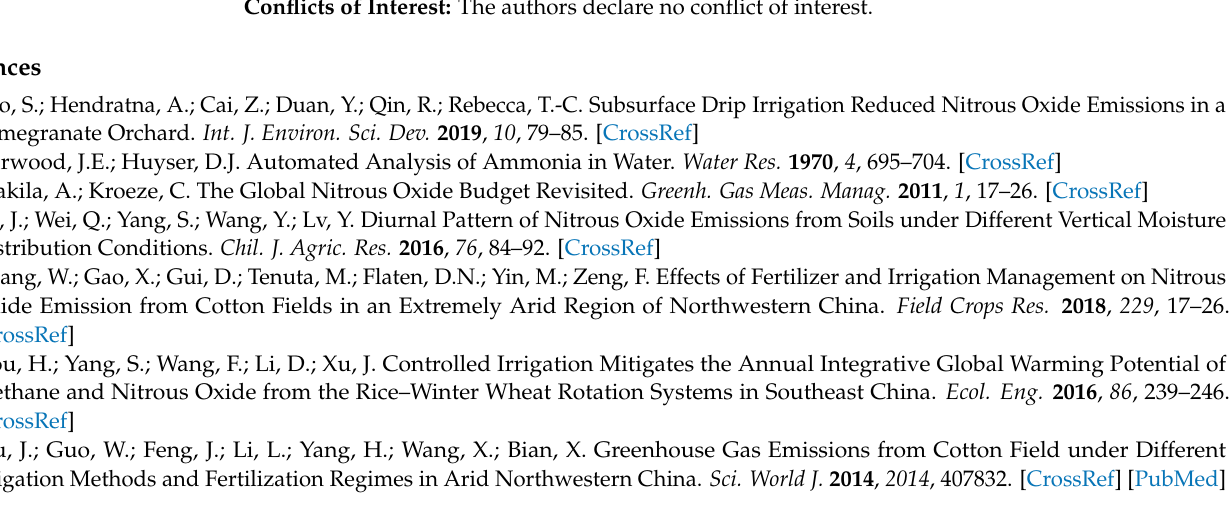
Supplementary Materials: The following are available online at https://www.mdpi.com/article/10 .3390/agronomy12030745/s1, Figure S1: Soil moisture distribution under SDI10+N300 treatment. letters a, b, and c represent first, second, and third irrigation events. The subscript numbers 1, 2, 3, and 4 denote sampling times of soil moisture subsequent to each irrigation; Figure S2: Soil moisture distribution under SDI15+N300 treatment. letters a, b, and c represent first, second, and third irrigation events. The subscript numbers 1, 2, 3, and 4 denote sampling times of soil moisture within each irrigation; Figure S3: Soil moisture distribution under SDI 10 + N 240 treatment. Letters a, b, and c represent first, second, and third irrigation events. The subscript numbers 1, 2, 3, and 4 denote sampling times of soil moisture subsequent to each irrigation; Figure S4: Soil moisture distribution under SDI 15 + N 240 treatment. letters a, b, and c represent first, second, and third irrigation events. The subscript numbers 1, 2, 3, and 4 denote sampling times of soil moisture within each irrigation, Table S1: Soil average ± standard deviation of WFPS% for SD15 treatments; Table S2: Soil average ± standard deviation of WFPS% for SD110 treatments; Table S3: Soil average ± standard deviation of WFPS% for SD115 treatments; Table S4: Soil average ± standard deviation of NH 4+ -N mg kg − 1 under SD15 treatments; Table S5: Soil average ± standard deviation of NH 4+ -N mg kg − 1 under SD110 treatments; Table S6: Soil average ± standard deviation of NH 4+ -N mg kg − 1 under SD115 treatments; Table S7: Soil average ± standard deviation of NO 3 − -N mg kg − 1 under SD15 treatments; Table S8: Soil average ± standard deviation of NO 3 − -N mg kg − 1 under SD110 Table S10: Correlations (R2) between N 2 O emissions and soil moisture at different depths under SDI10; Table S11: Correlations (R2) between N 2 O emissions and soil moisture at different depths un- der SDI15; Table S12: Correlations (R2) between N 2 O emissions and soil NH 4+ -N at different depths under SDI5; Table S13: Correlations (R2) between N 2 O emissions and soil NH 4+ -N at different depths under SDI10; Table S14: Correlations (R2) between N 2 O emissions and soil NH 4+ -N at different depths under SDI15; Table S15: Correlations (R2) between N 2 O emissions and soil NO 3 − at different depths under SDI5; Table S16: Correlations (R2) between N 2 O emissions and soil NO 3 − at different depths under SDI10; Table S17: Correlations (R2) between N 2 O emissions and soil NO 3 − at different depths under